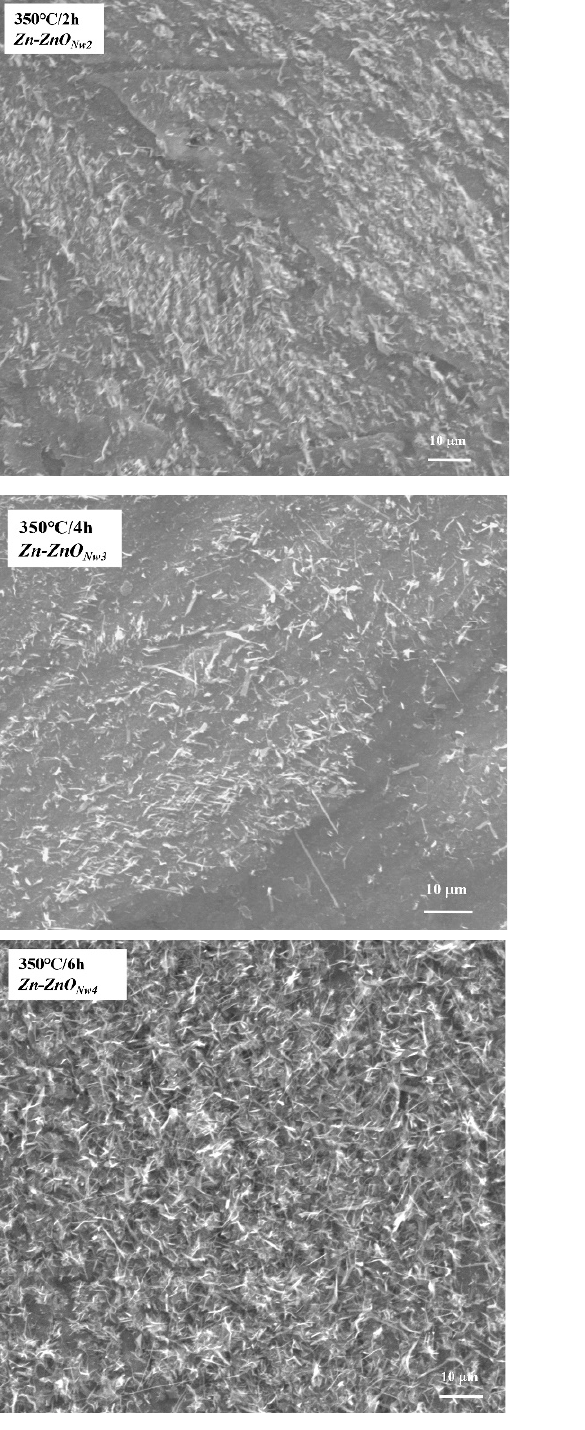
Figure 4. SEM morphologies of the Zn foil and Zn- ZnO Nw layers. The morphologies of the as-obtained ZnO Nw @CMO sensors are presented in Figure 5. From the images, it can be observed that CuMnO 2 films completely coated the Zn-ZnO (NW) layers in the case of the ZnO Nw 2 @CMO, ZnO Nw 3 @CMO and ZnO Nw 4 @CMO sensors, instead of the ZnO Nw5 @CMO, ZnO Nw6 @CMO and ZnO Nw7 @CMO sensors the CuMnO 2 film presents a nonuniform coating on the ZnO NWs, because of random growing of the ZnO NWs on the Zn foil surface.